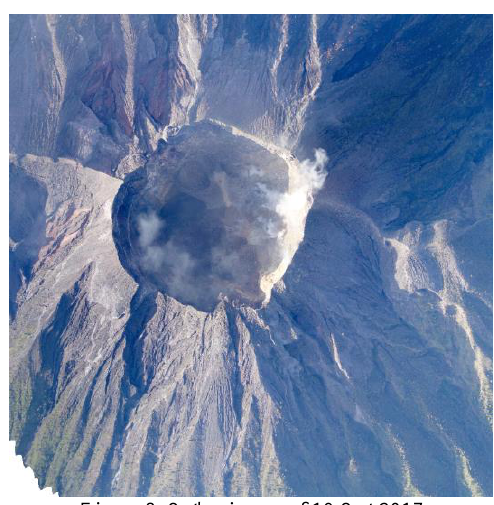
Figure 7. Ortho-image of 21 Oct 2017